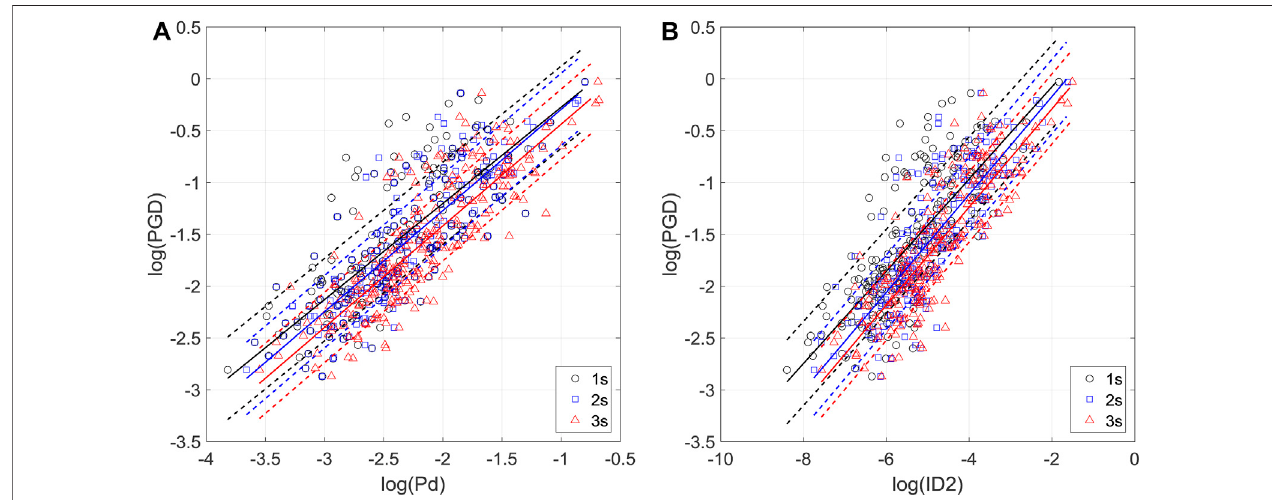
FIGURE 4 | (A – B) show P d and ID2 calculated from the fi rst 1 s (dark circles), 2 s (blue squares), and 3 s (red triangles) of P wave data, respectively. The PGD regression relationships determined by this study are shown as solid lines, and the standard deviations are shown as dashed lines.